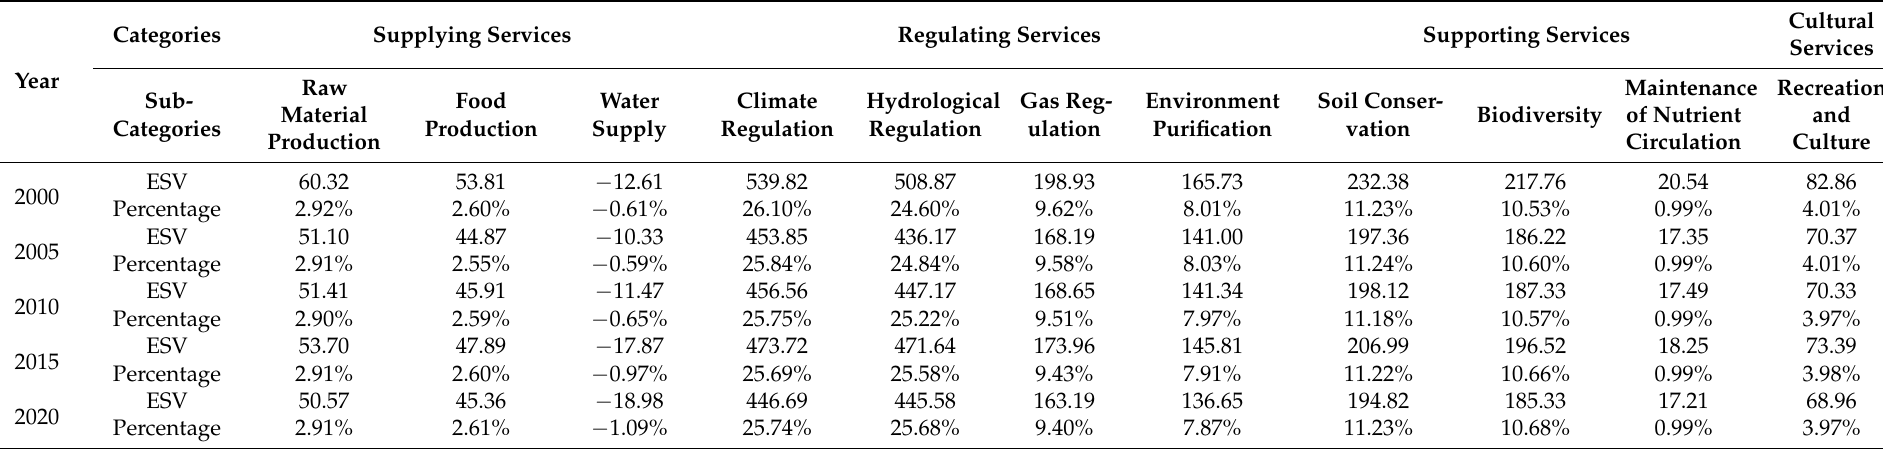
Table 9. Proportion of ESV and ESV by different categories of ecosystem services in Hainan Province (unit: 10 6 CNY).